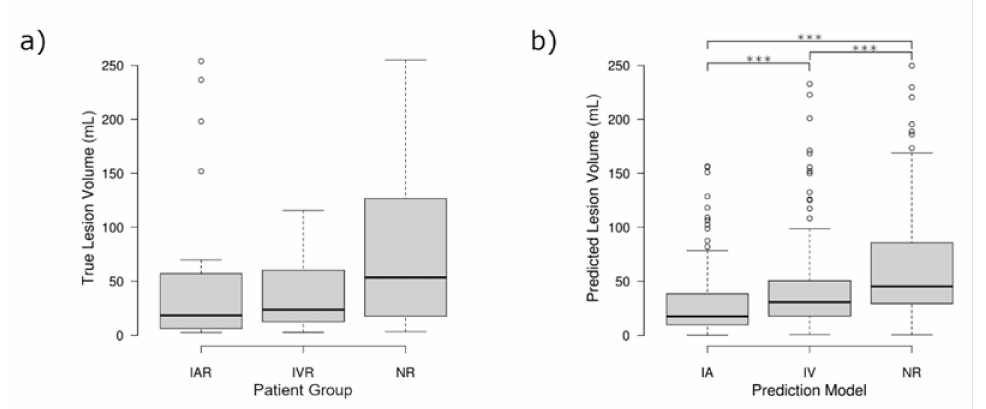
Figure 3. Boxplots representing the distribution of lesion volumes calculated for ( a ) the expert- segmented follow-up lesions, separated by the treatment outcome of the patient, ( b ) the predicted follow-up lesion, separated by predicted treatment outcomes. Recanalization outcomes are ab- breviated IAR (intra-arterial therapy, recanalizing), IVR (intravenous tPA, recanalizing), and NR (non-recanalizing). Significance markers (***) represent p < 0.001 for post-hoc tests following the one-way ANOVA performed in ( a ) and the one-way repeated-measures ANOVA performed in ( b ). Circular markers represent outliers with values more than 1.5 times the interquartile range.